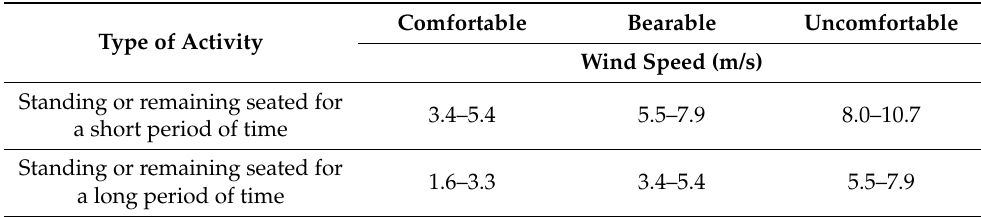
Table 1. Relative comfort